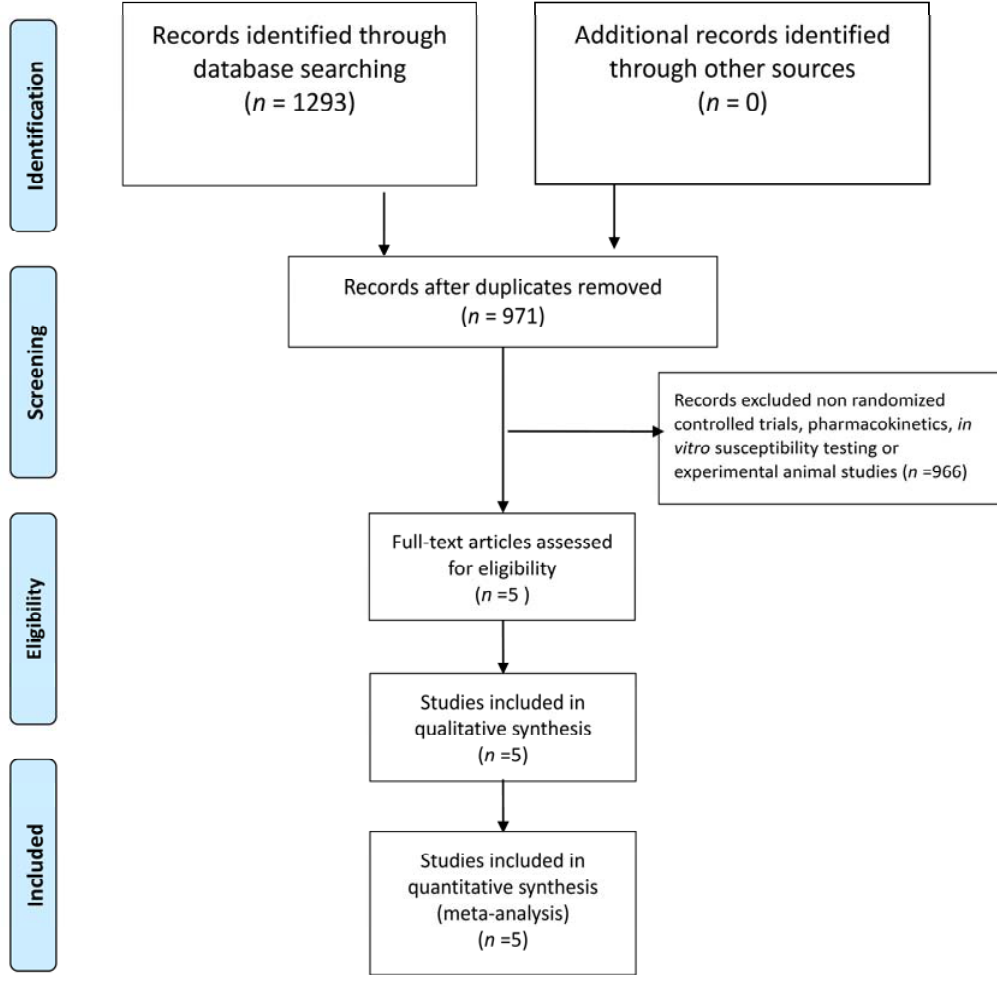
Figure 1. The flow-chart of study Figure 1. The flow ‐ chart of study selection.